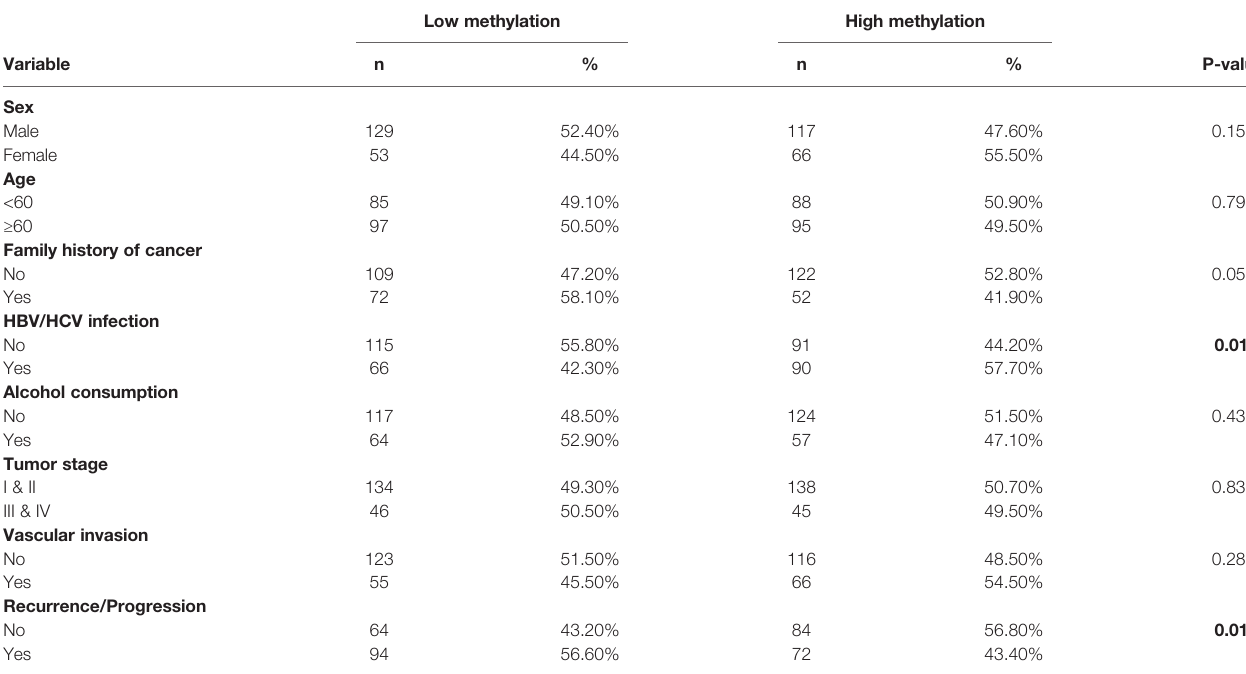
TABLE 1 | The association between RNF135 promoter methylation level and clinical characteristics of patients with HCC from the